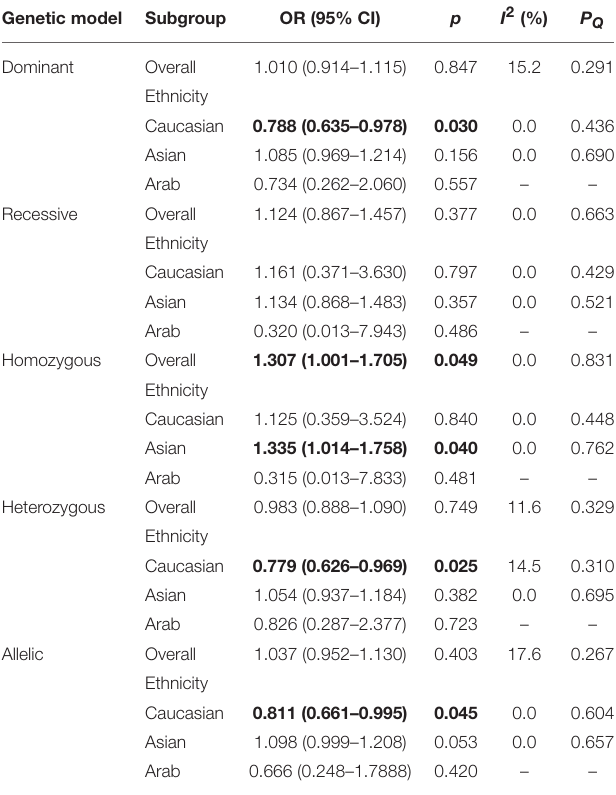
TABLE 2 | Meta-analysis and heterogeneity test of the Ghrelin Leu72Met polymorphism and T2DM susceptibility. Genetic model